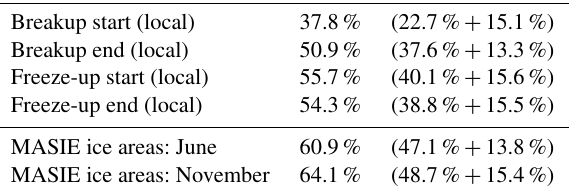
Table 4. Percentages of variance explained by Factors 1 and